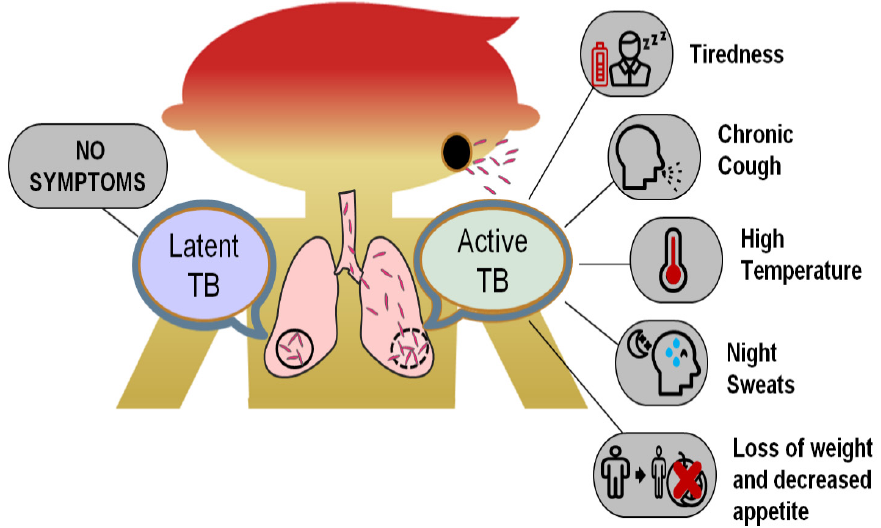
Figure 1. Diagrammatic representation of symptoms of active and latent TB.